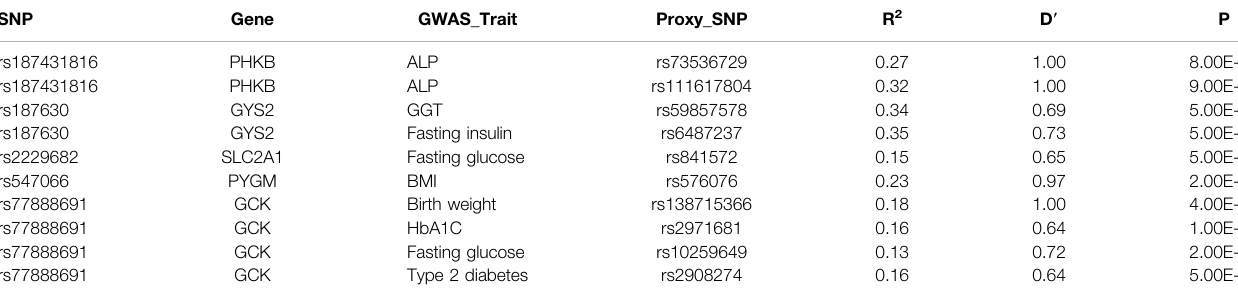
TABLE 3 | Pleotropic effects of PDFF associated SNPs on liver function or metabolic traits. SNP Gene